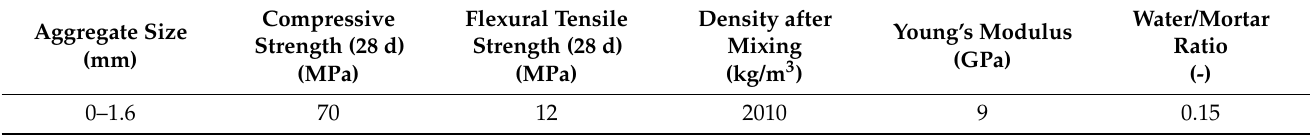
Table 2. Properties of the cementitious matrix, based on [30].